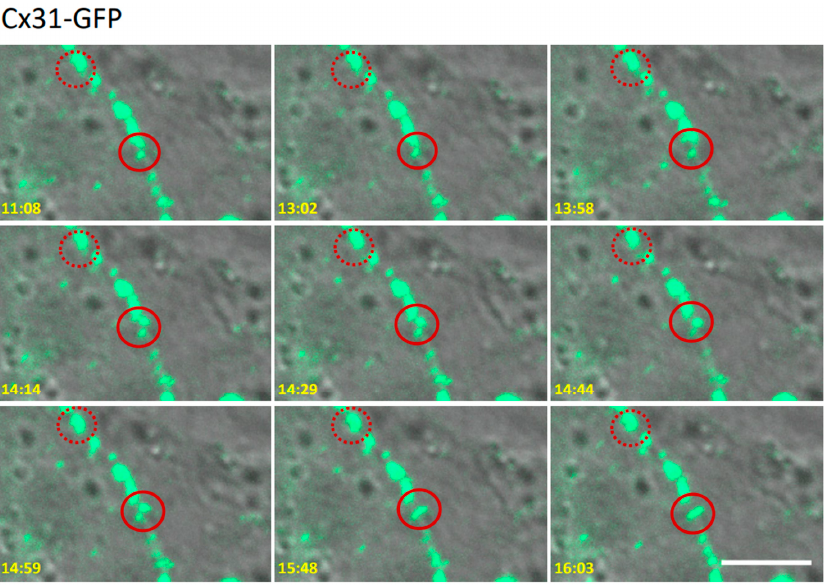
Figure 8. Time-lapse imaging revealed that Cx31-GFP gap junctions were motile at cell-cell interfaces undergoing both plaque fusion and fission. Time-stamped images are presented to denote how some gap junctions remained static over 5 min of time-lapsed imaging (dashed circle) while others (solid circle) underwent rearrangement involving apparent fission and fusion events. Bar = 10 μ m. Other Cx31 gap junctions remained stable and served as an imaging reference point to eliminate